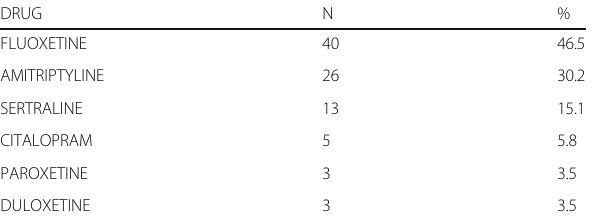
Table 1 (abstract O80). Antidepressants most used in the sample DRUG N % FLUOXETINE 40